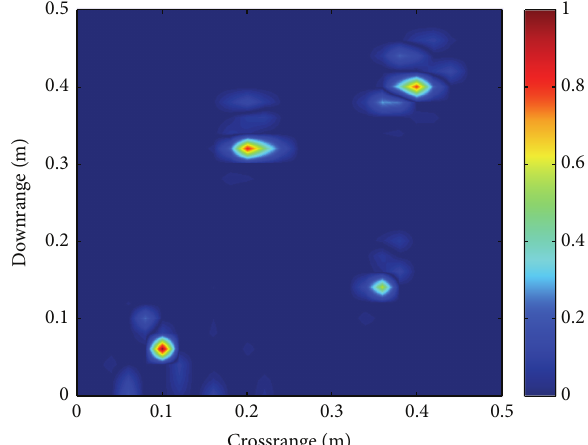
where 𝑀 𝑠 is the number of species of media, 𝜒(𝜔) is the medium susceptibility, 𝜔 𝑝 is the resonant frequency for the 𝑝 species, and 𝛼 𝑝 is the corresponding damping factor and 𝜀 𝜀 𝑠 and ∞ are the static and infinite frequency permittivities, respectively.